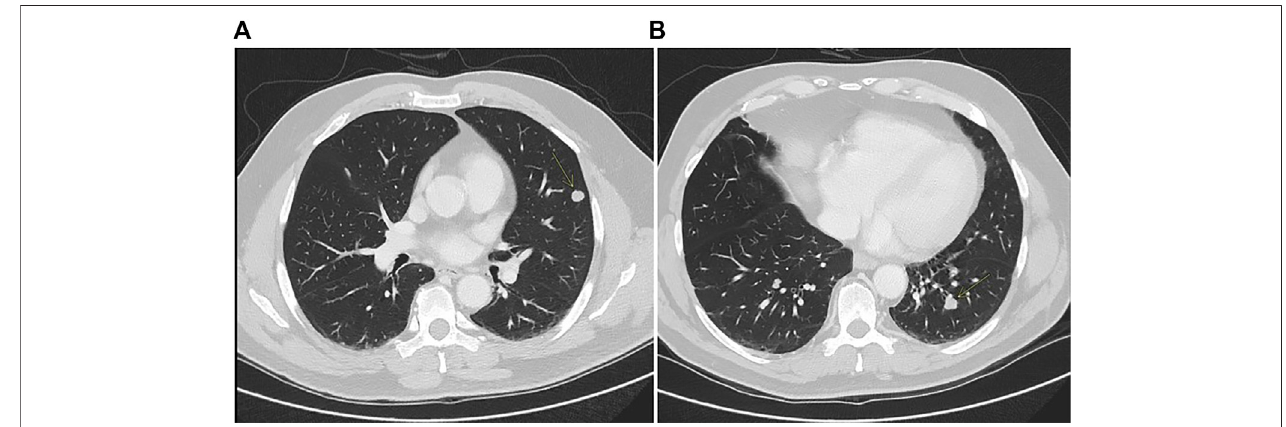
FIGURE 2 | CT scan showing left lung metastases (A,B)